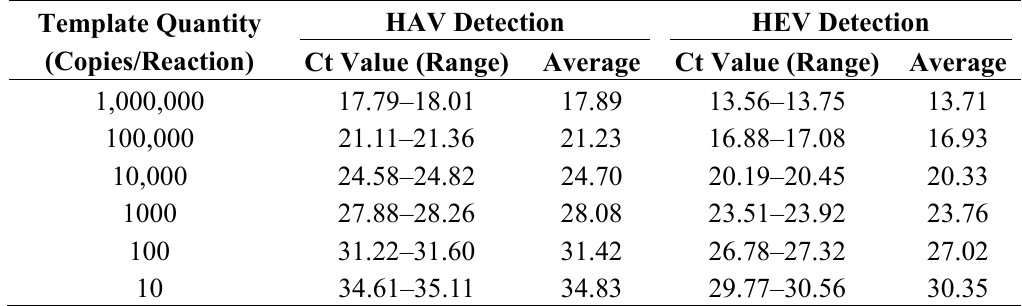
Table 1. Precision and reproducibility analysis of HAV-HEV multiplex real-time